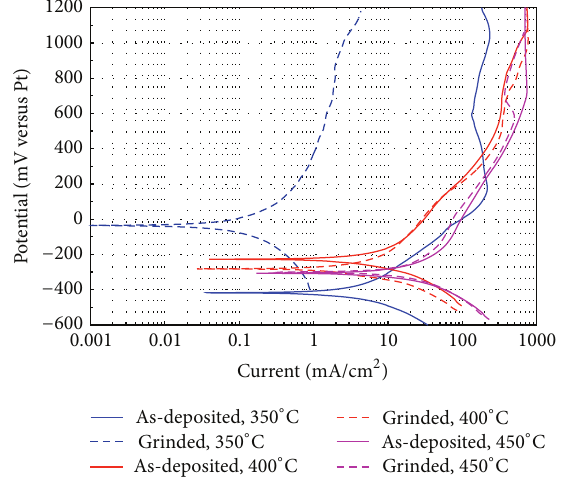
Figure 4: Polarization plots of Ni20Cr coatings in KCl-ZnCl 2 at the different